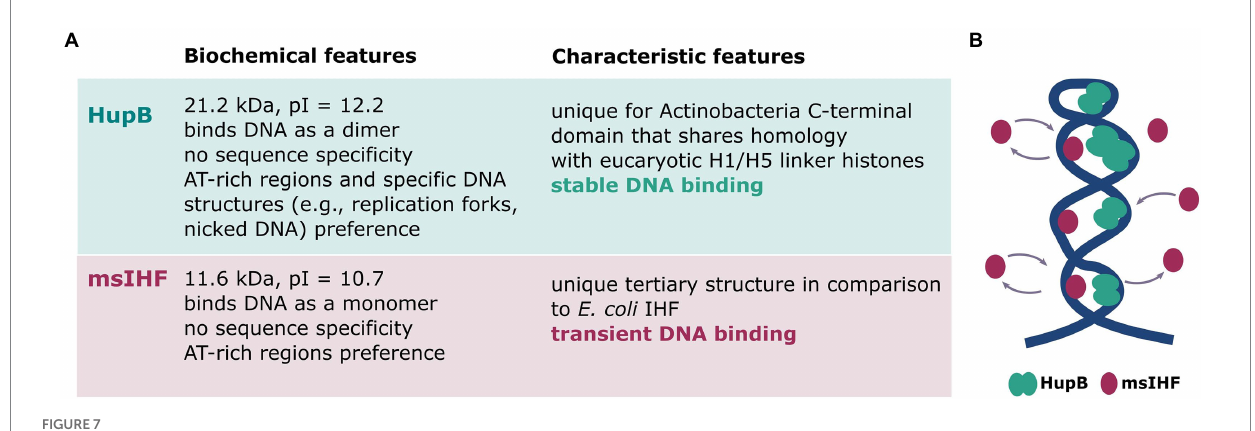
FIGURE 7 Characteristics of HupB and msIHF. (A) Biochemical characteristics of msIHF and HupB (Kumar et al., 2010; Bhowmick et al., 2014; Odermatt et al., 2018, 2020a). (B) Hypothetical model of the interplay of msIHF and HupB in local-scale chromosomal DNA binding. HupB molecules create a scaffold to maintain the local structure of the chromosomal DNA, and msIHF particles transiently bind the